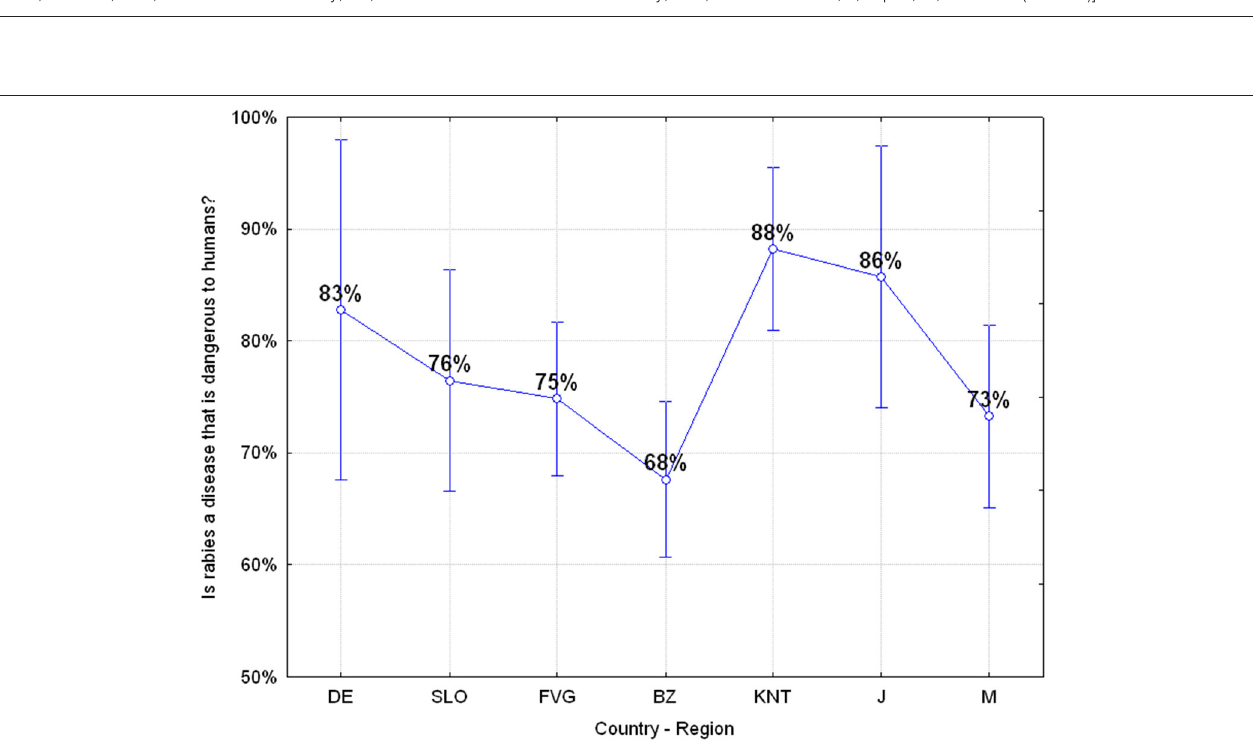
FIGURE 12 | Q26: “Is rabies a disease that is dangerous to humans?” ANOVA F (6,649) p = 0.00295 [Axes X regions or countries, Axes Y % correct answers–DE, Germany; SLO, Slovenia; FVG, Friuli Venezia Giulia Italy; BZ, Autonomous Province of Bolzano Italy; KNT, Carinthia Austria; J, Japan; M, Mauritius–( n = 656)].